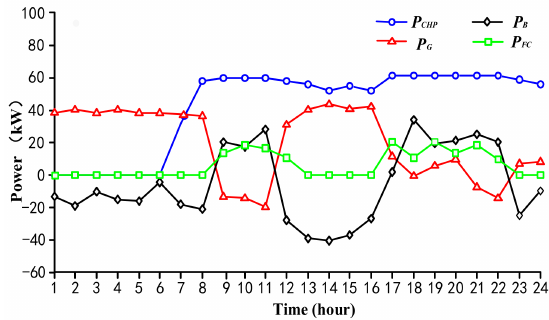
Figure 5. The optimal output power of different energy generators at β =